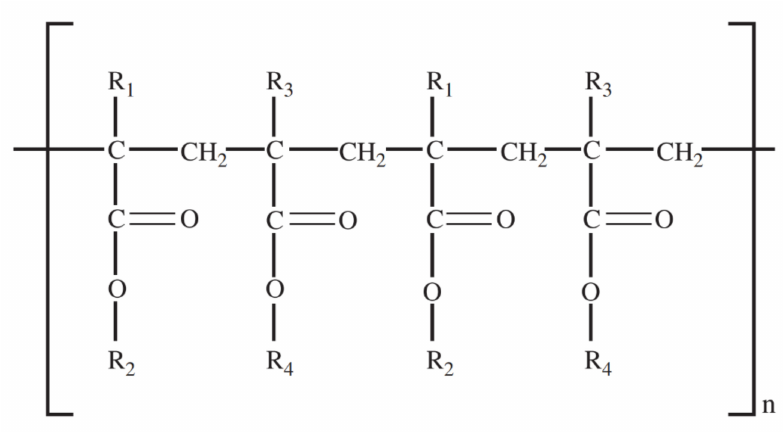
Figure 1. Main structural skeleton of Eudragit